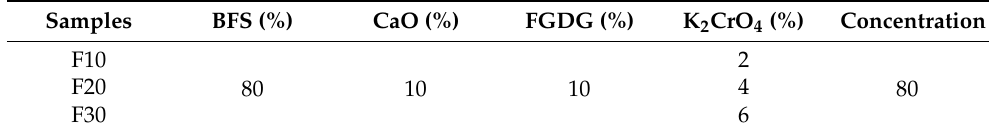
Table 2. The samples investigated for solidification mechanism of Cr in Friedel’s